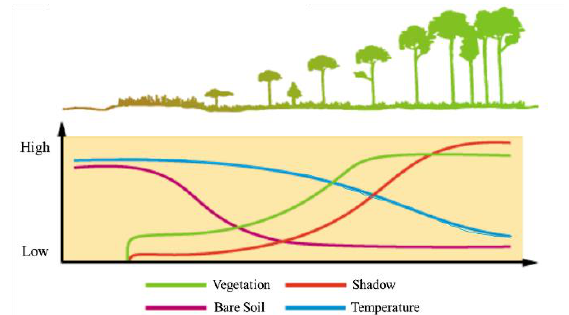
Figure 2. The Characteristics of four indices for forest condition.